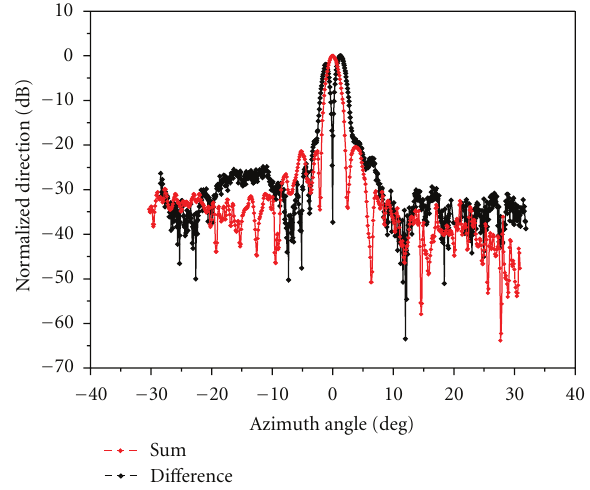
Figure 13: Normalized Direction of sum-di ff erence signal at 94GHz. Table 1: Optimized value of all